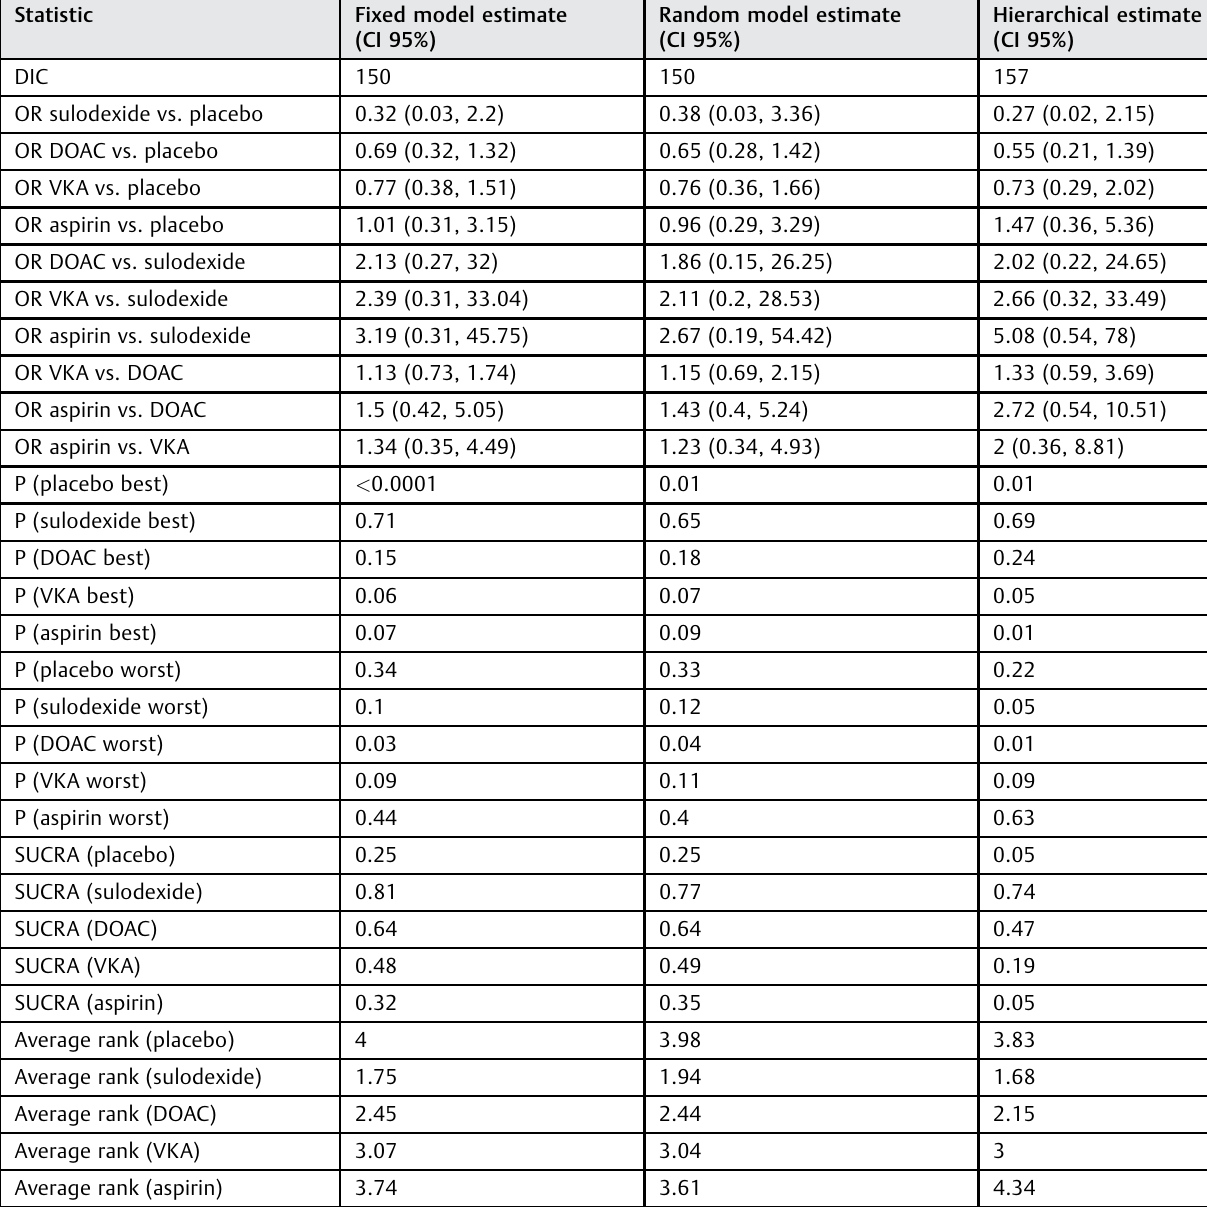
Table 5 Main results for death from VTE/PE/MI/stroke, all studies